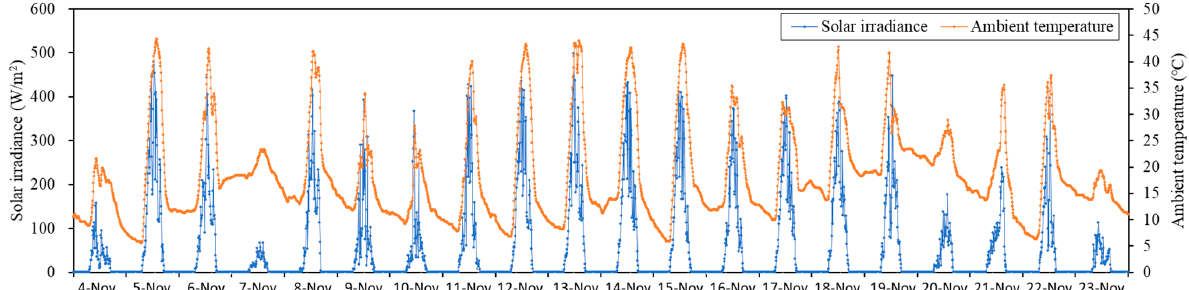
Figure 1. Solar irradiance and ambient temperature of the greenhouse during hydroponic cultivation. Table 1. Composition and concentration of the standard nutrient solution OTA fertilizer A.